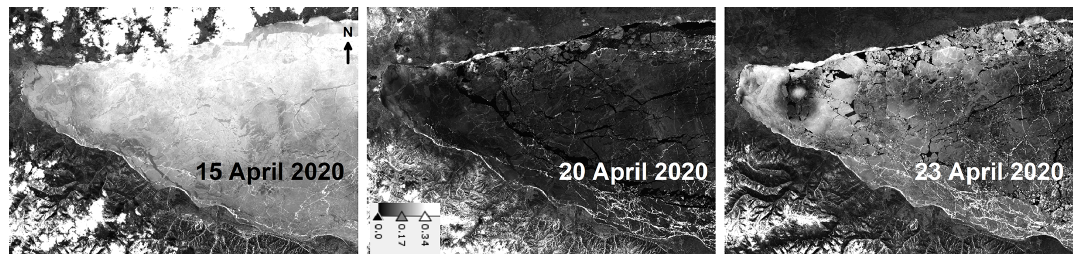
Figure 2. A sequence of Sentinel-2 images (red band, Level 2A – bottom-of-atmosphere reflectance with atmospheric correction) for southern Baikal on 15, 20 and 23 April 2020. Colour scheme is the same for the three images. The ice ring that looks like a fish eye is located in the westernmost part of southern Baikal. The dark aspect of ice on 20 April is related to very low reflectance, and its causes are explained in Sect. 4.1. Projection UTM 48N. Table 1. Satellite data used in this study, their spatial resolution (metre, numerical values) in various parts of the spectrum and intensity of signal on satellite images and data for various surface types. Ranges Satellite Surface types and intensity of their signal on satellite data